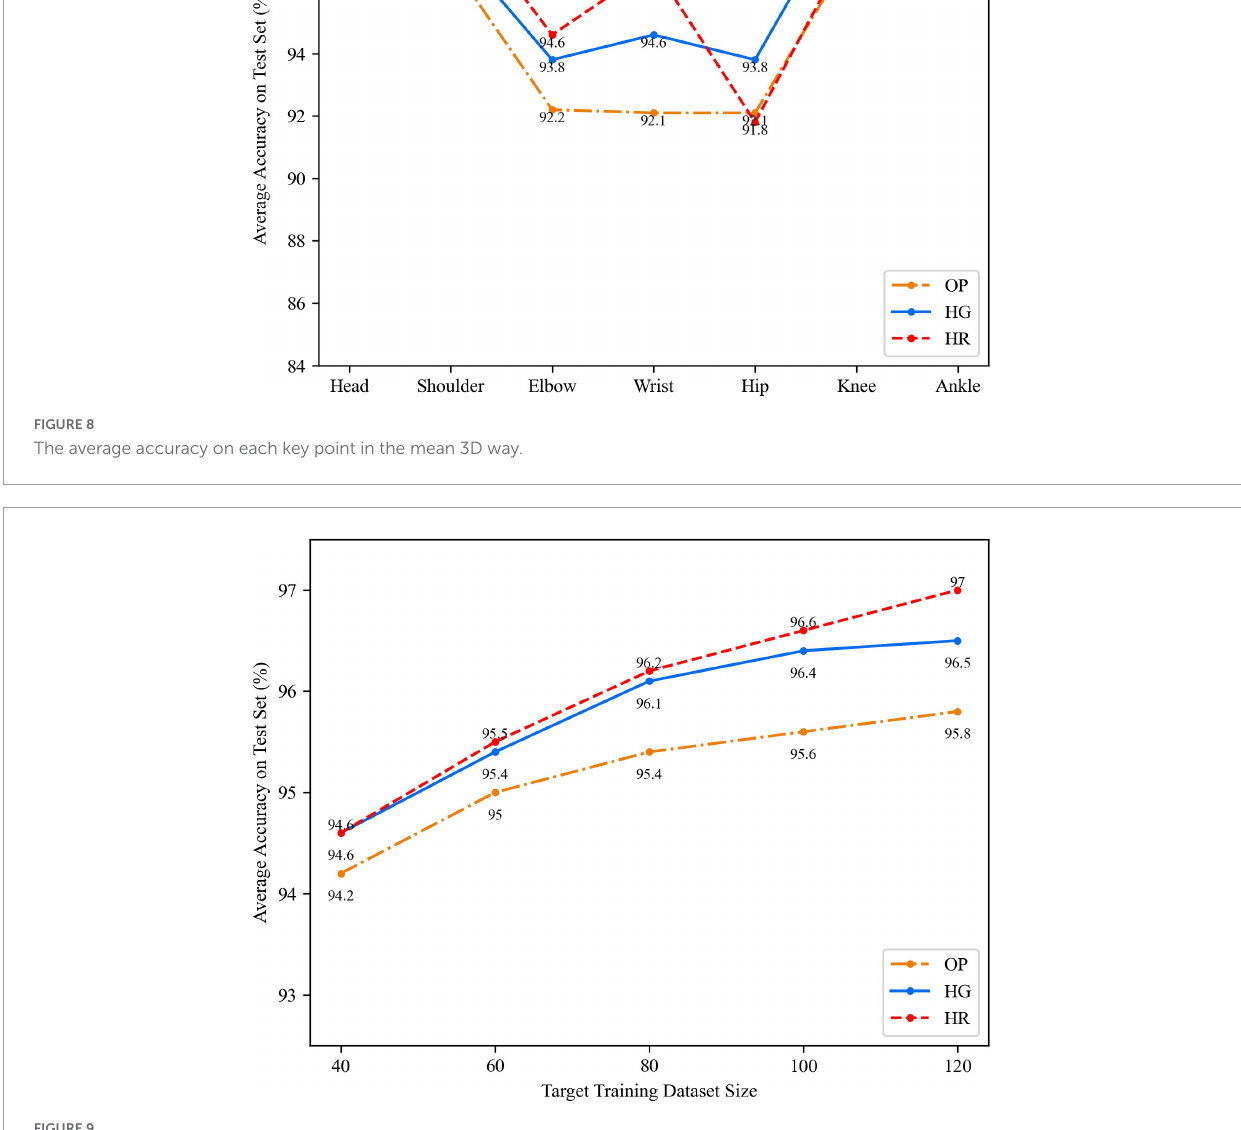
FIGURE9 The total average accuracy of different networks after model transfer.